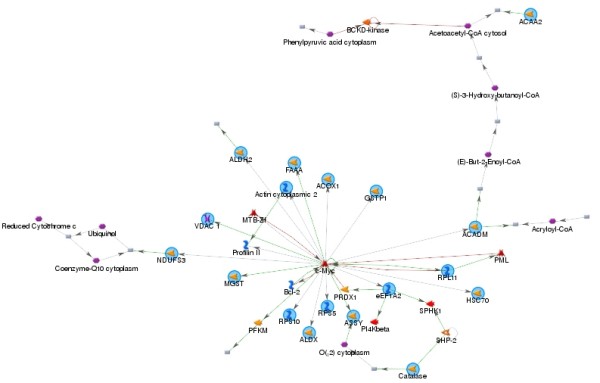
Pathway analysis result showing 18 differentially expressed proteins following 50% PH can be sorted into the c-myc pathway. There are 18 root nodes in the sub-network shown, of which ACAA2, ALDH2, ACOX1, GSTP1, ACADM, ASS1(ASSY) are up-regulated and VDAC1, MGST, RPL11, ALDX, RPS5 are "newly-induced" in response to 50% PH; ACTG1(Actin cytoplasmic 2), HSPA8(HSC70), CAT(catalase) are down-regulated and FAH(FAAA), NDUFS3, RPS10, eEF1A2 are below detection limit. These root nodes are connected to c-Myc directly or indirectly, and their expression levels or activities can be regulated by c-Myc, and some of them (such as RPL11) can regulate c-Myc activity in a feedback manner. Legend describing symbols in the network can be found in Additional file 1.